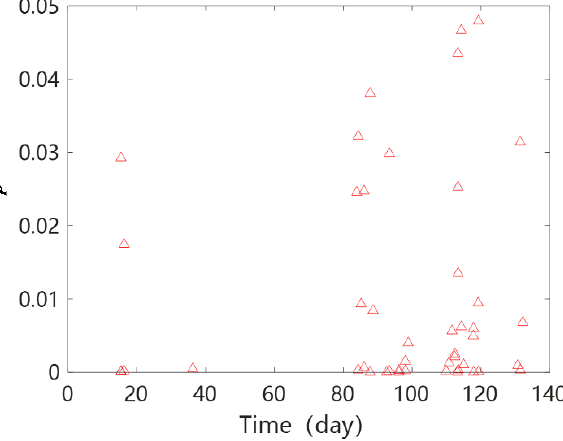
Figure 9. Results of joint significance evaluation of acoustic data.